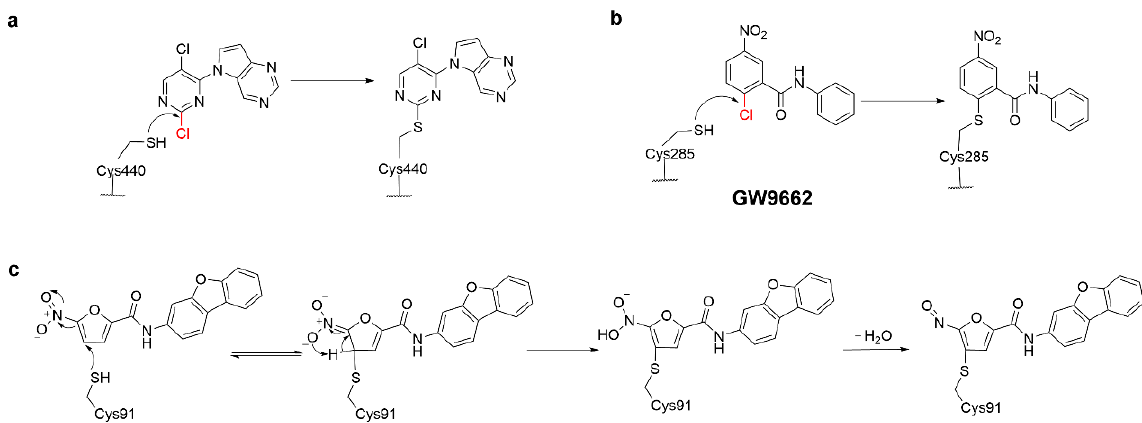
Figure 3. The mechanism of covalent nucleophilic aromatic substitution ( a ) 2, 5 ‐ dichloropyrimidine with cysteine, ( b ) GW9662 with cysteine, and ( c ) mechanism of the reaction of C ‐ 178 with Cys91.